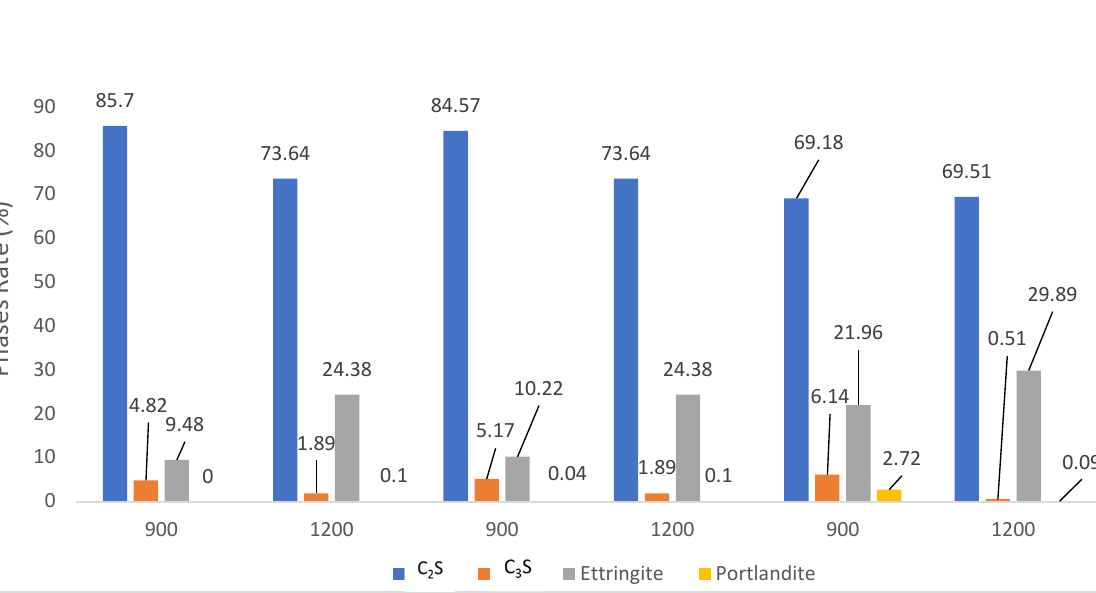
Figure 9. Phases quantifications of the hydrated cement produced by indirect mechanosynthesis after